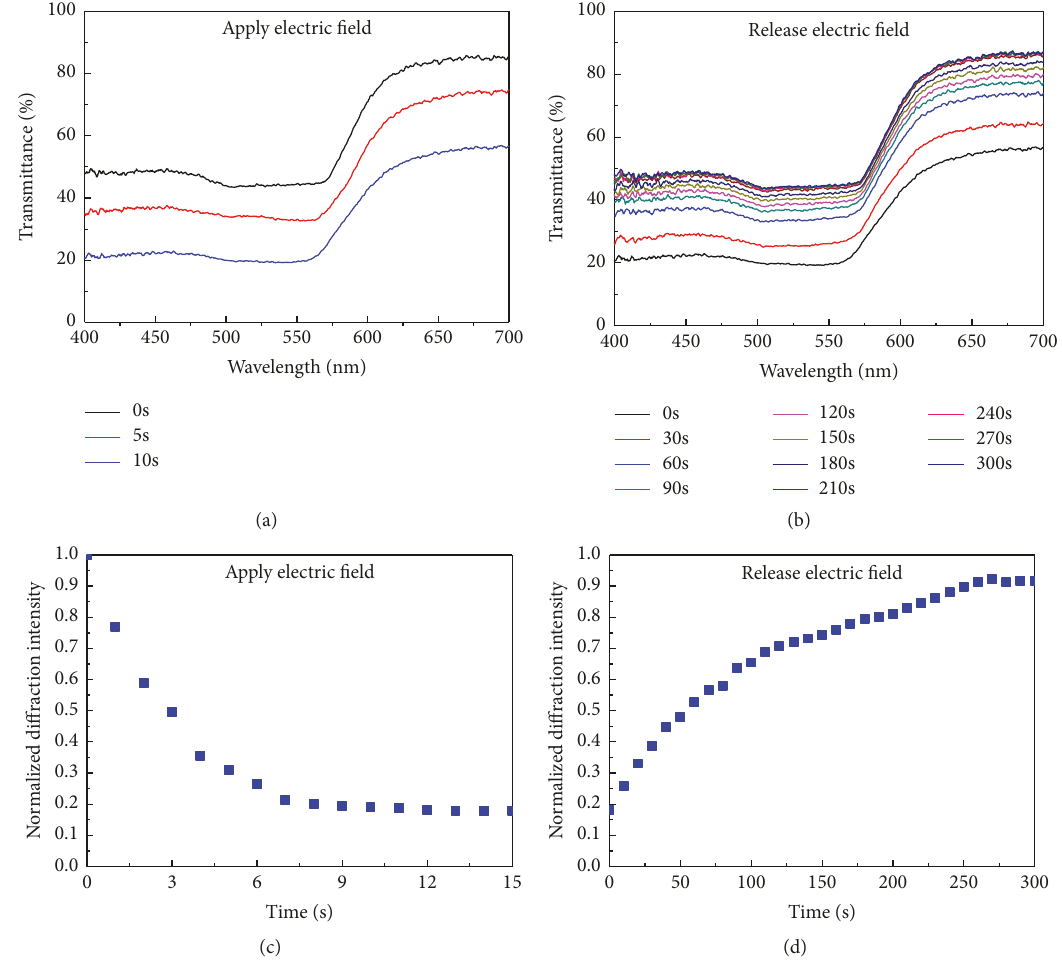
Figure 6: Dynamical variations of (a)/(b) the transmittance and (c)/(d) diffraction intensity of the refilled CLC template grating when (a, c) applying and (b, d) releasing the electric